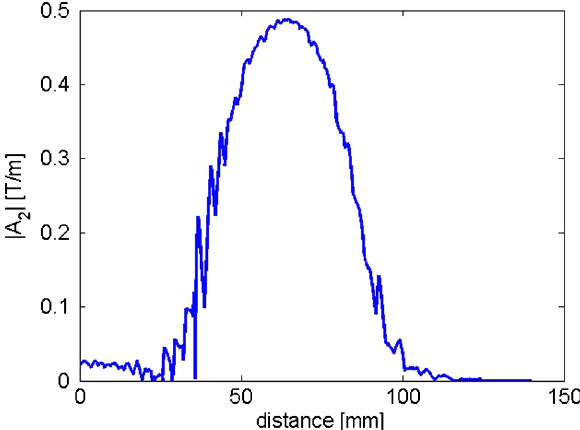
18. Absolute value of the quadrupole gradient calculated using Eq. (A1) for r 0 ¼ 8 where B and B are the maximum and minimum of max min the magnetic field at a certain distance r 0 from the axis and at a given longitudinal coordinate z . Figure 18 shows the absolute value of the quadrupole gradient for r ¼ 8 mm.